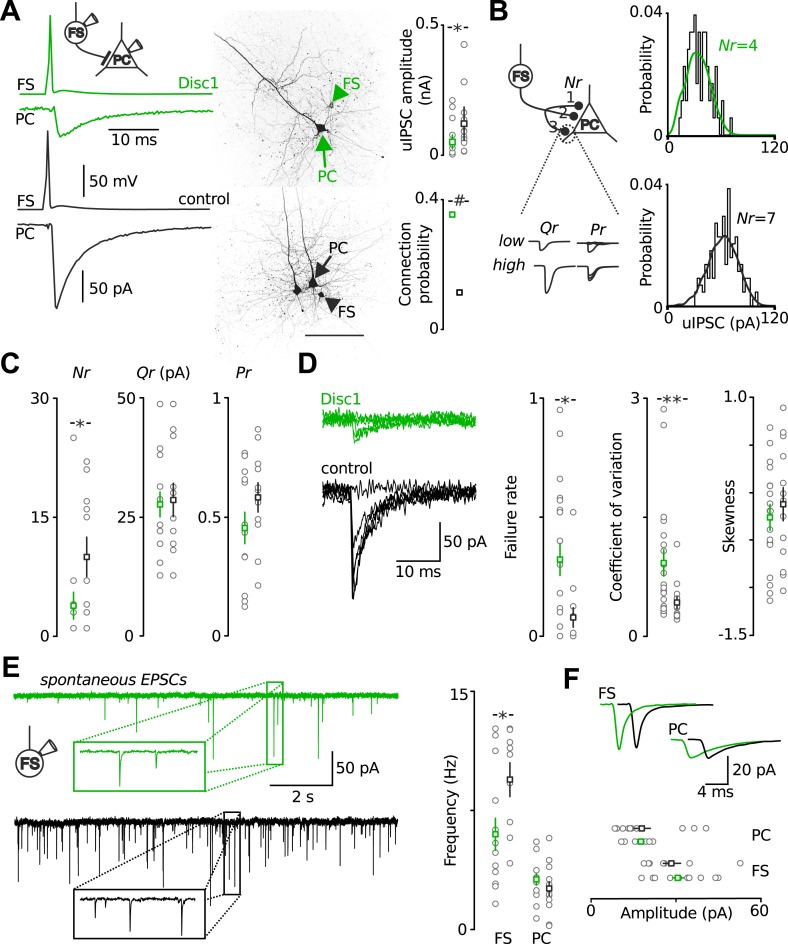
Output and input signalling of FS-INs are impaired in the Disc1 PrlC.(A) Paired recordings of FS-INs and PCs revealed a reduction in uIPSC amplitude in the PrlC of Disc1 mice (50.8 ± 13.3 vs 121.1 ± 32.1, n = 20, 13 pairs, p = 0.012) but enhanced connection probability (35.4 vs 11.5%, n = 65, 122 simultaneous recordings, p < 0.001). Scale, 100 µm. Middle, confocal images of the pairs. (B) Amplitude distributions of uIPSCs of a Disc1 and control pair. Lines represent best fit results obtained by multiple probability compound binomial analysis. (C) Nr but not Qr or Pr are reduced at Disc1 FS-IN synapses (Nr: 4 ± 2 vs 10 ± 2, p = 0.036; Qr: 27.6 ± 2.6 vs 28.5 ± 3.5, p = 0.831; Pr: 0.45 ± 0.07 vs 0.58 ± 0.06, p = 0.340, n = 14, 11 pairs). (D) Left, superimposed single traces of a Disc1 and control pair. Failure rate, coefficient of variation, and skewness of uIPSCs support reduced Nr (0.32 ± 0.07 vs 0.08 ± 0.04, p = 0.015, 0.92 ± 0.17 vs 0.43 ± 0.07, p = 0.008, −0.262 ± 0.135 vs −0.124 ± 0.174, p = 0.503, respectively, n = 17–20, 13 pairs). (E) Reduced frequency of spEPSCs in Disc1 FS-INs (6.0 ± 1.0 vs 9.5 ± 1.1 Hz, p = 0.022, n = 15, 9) but not PCs (3.1 ± 0.4 vs 2.6 ± 0.4, p = 0.246, n = 11, 13). (F) Unchanged spEPSC amplitudes (FS-INs: 30.7 ± 2.3 vs 28.7 ± 3.4 pA, p = 0.340, n = 15, 9 cells; PCs: 17.9 ± 1.1 vs 18.4 ± 3.0 pA, p = 0.246, n = 11, 13 paris). *p < 0.05, #p < 0.001. Data are mean ± SEM, circles individual cells.